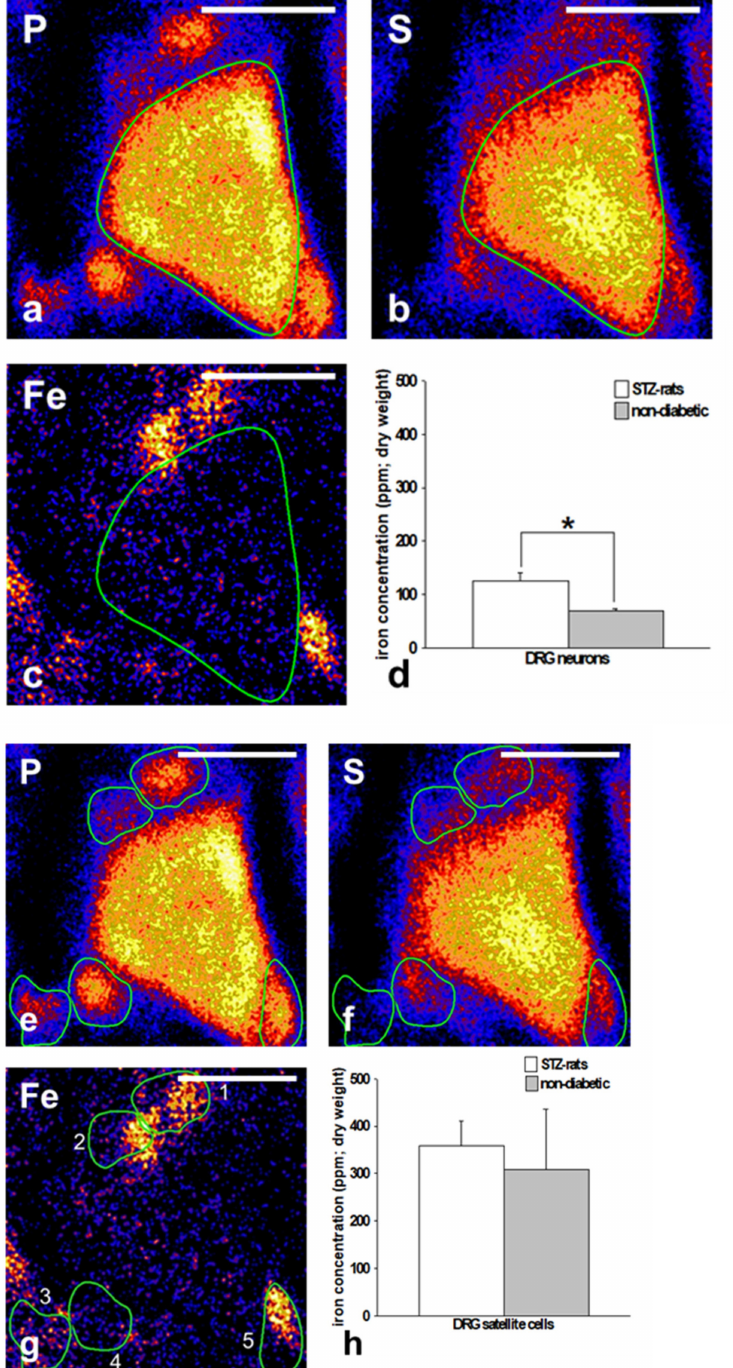
Figure 3. PIXE imaging of elementary phosphorous, sulfur (for cell area visualization) and iron particles in cells of dorsal root ganglions (DRG) [12]. ( a – c ): an example of the DRG neuron (marked with a drawn green line). ( e – g ): an example of DRG satellite cells (marked with a drawn green line). ( d , h ): Intracellular iron concentration: ( d ): The iron concentration was significantly higher in